Question: Generate an informative caption for the figure above.
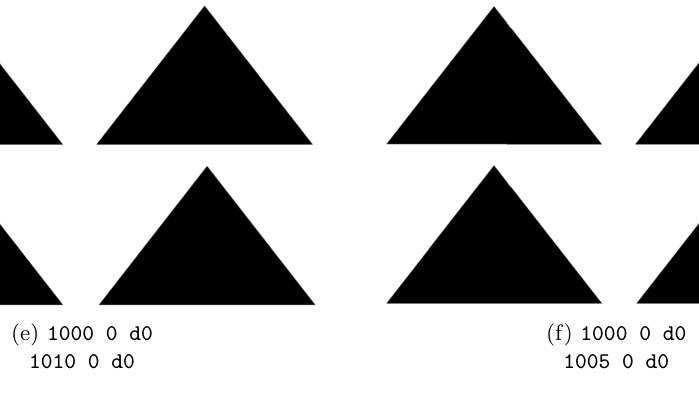
Answer: d0 Operator - control, 10%, 5%, 2%, 1%, 0.5% (1%)